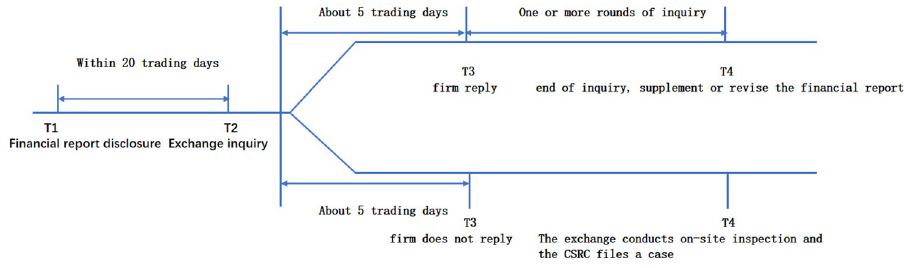
Fig 1. Inquiry process of financial reporting in China’s stock